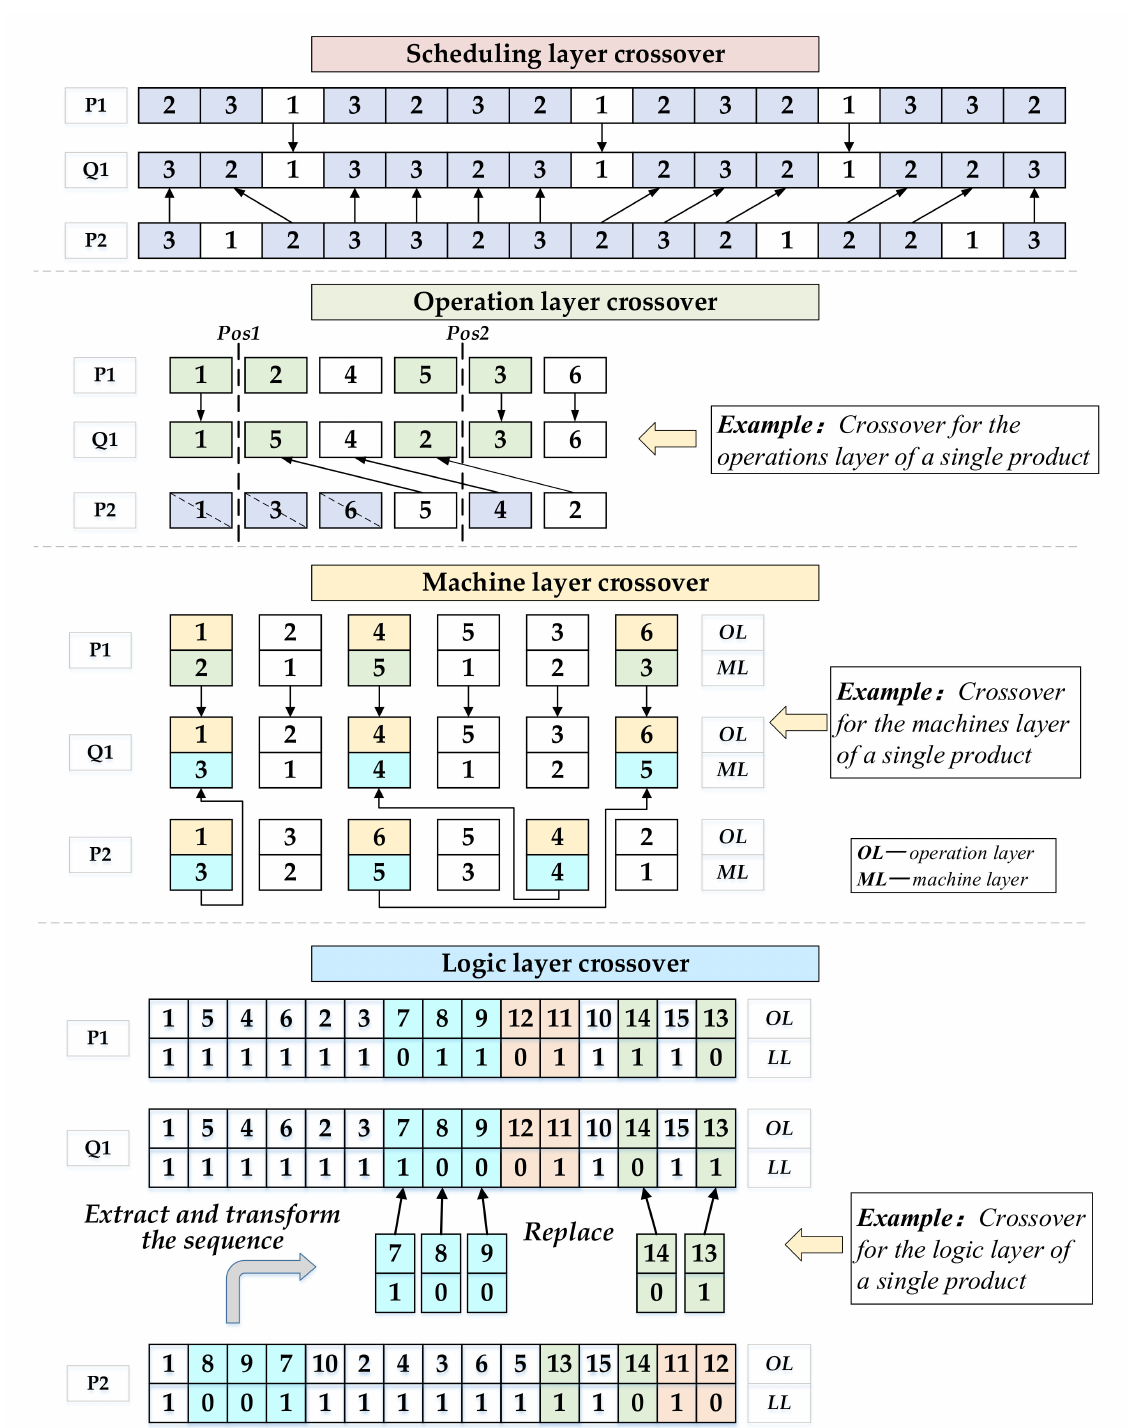
Figure 7. Illustration of crossover operators for di ff erent coding